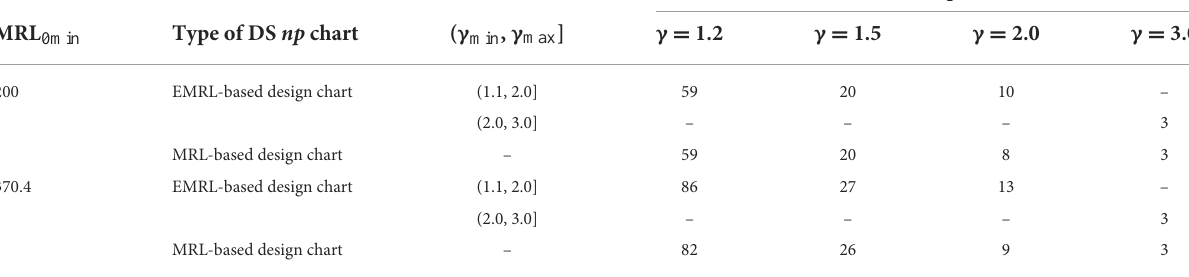
TABLE 4 MRL 1 computed using the optimal charting parameters of the EMRL-based DS np chart and the MRL-based DS np chart for p 0 = 0.005, n = 100, and EMRL 0 ∈{ 200, 370.4 } .